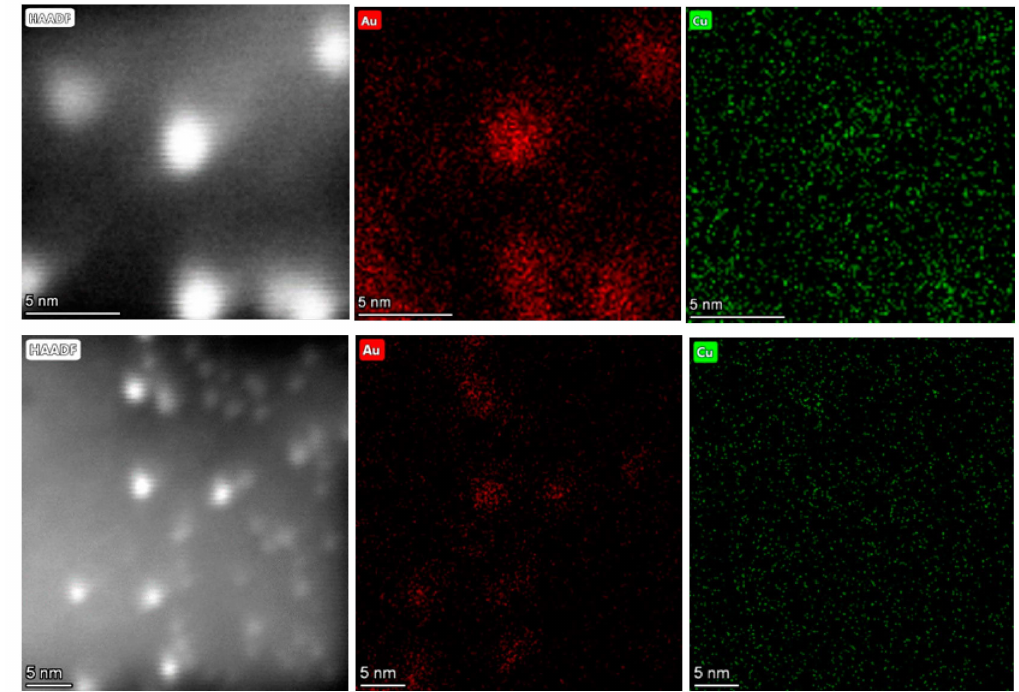
Figure 3. HAADF image with Au and Cu elemental maps (background corrected and fit Au-L and Cu-K intensities, respectively) recorded during the STEM-EDS measurement of Au 4 Cu 1 sol.